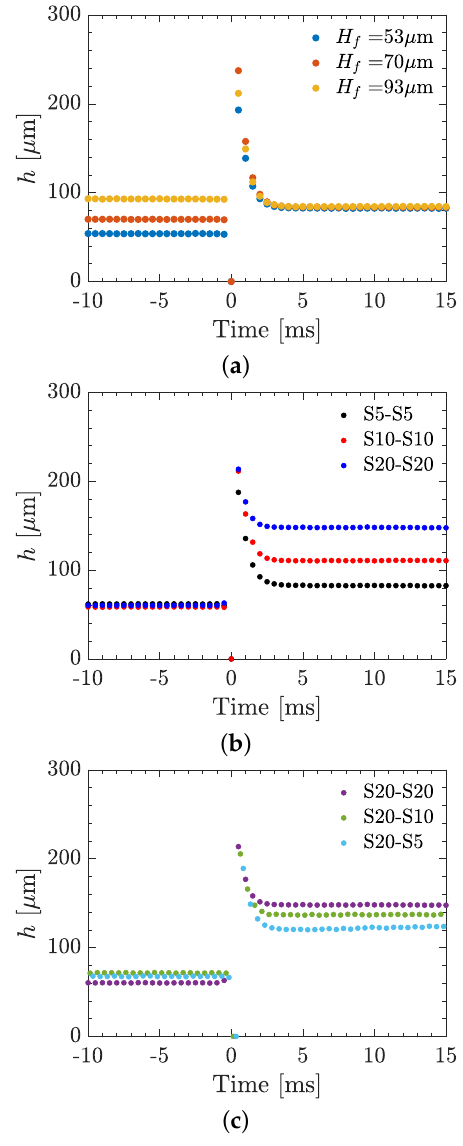
Figure 4. Evolution of the film thickness at the impact axis x = x c for ( a ) various initial wall film thicknesses H f for the same combination of the liquids, S5 − S5, ( b ) various drop viscosities and ( c ) various liquid wall film